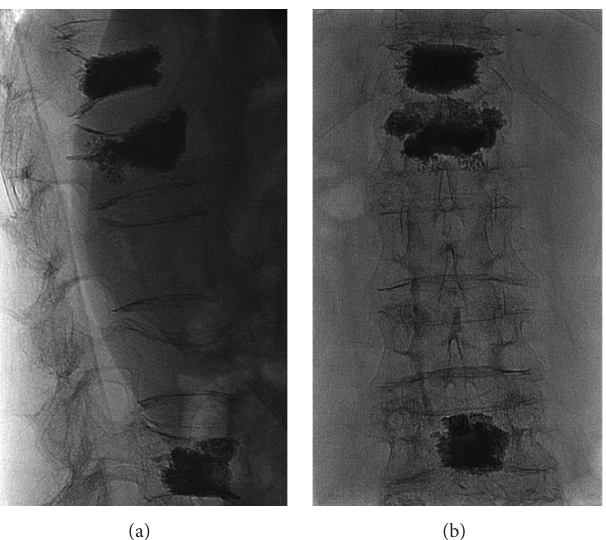
F 2: Fluoroscopic biplanar control postprocedure in the lateral (a) and anteroposterior (b). Optimal and uniform distribution of polymethylmethacrylate (PMMA) within the bodies of D12, L1, and L4. e postprocedural �uoroscopic control is necessary to ensure that the PMMA does not extend into the prevertebral space, the dural sac, or in the paravertebral vessels.